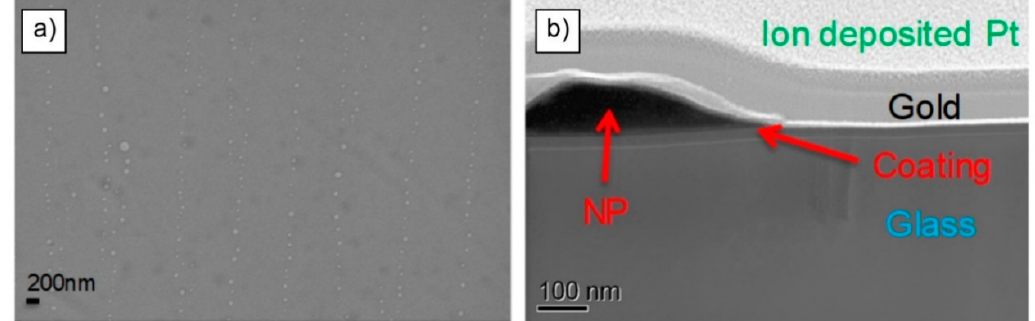
Figure 13. SEM planar view images of the coating surface showing ( a ) localized blistering and blister eruption after 400 h of DH; ( b ) blistering after 1000 h of DH, and ( c ) delamination of a coating after 1000 h of UV exposure observed on various tested coatings B and C.